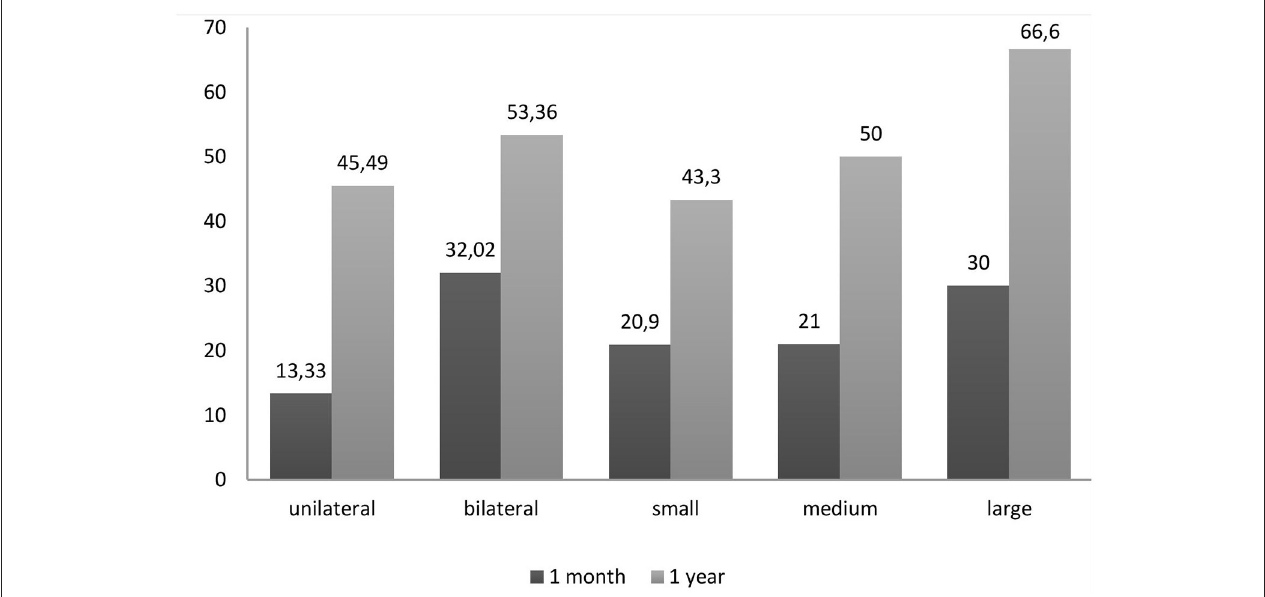
FIGURE 1 | Percent mortality based on the distribution and size of the PE. Patients with large effusions exhibited higher mortality than patients with small effusions, while patients with bilateral effusions exhibited higher mortality than patients with unilateral effusions.